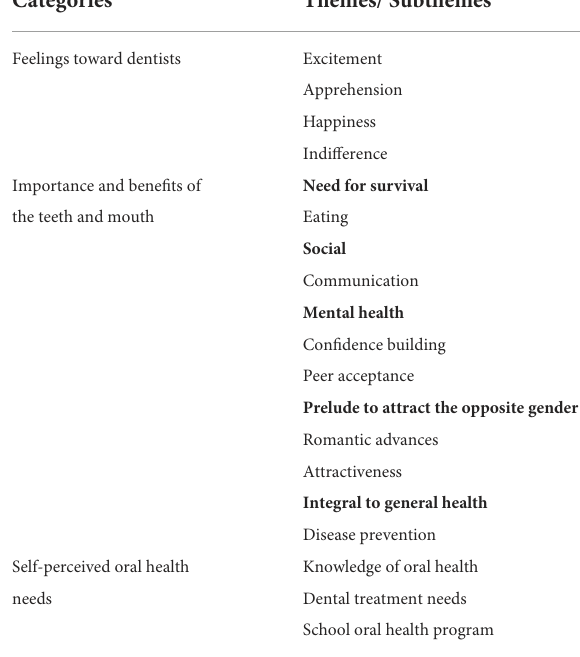
TABLE 2 Categories themes and subthemes emerging from the